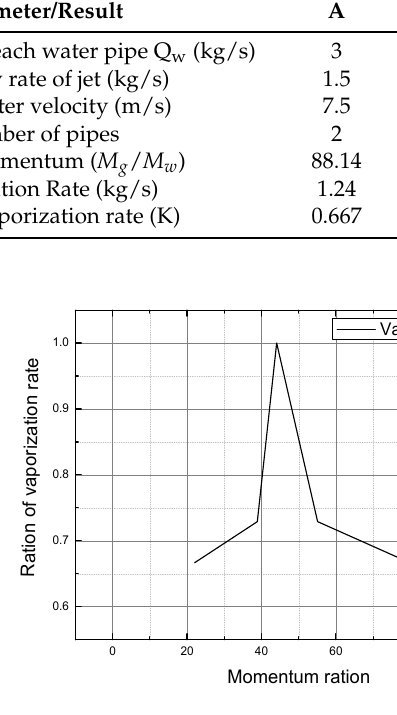
Figure 17. Dimensional polylines between momentum ratio and vaporization rate.